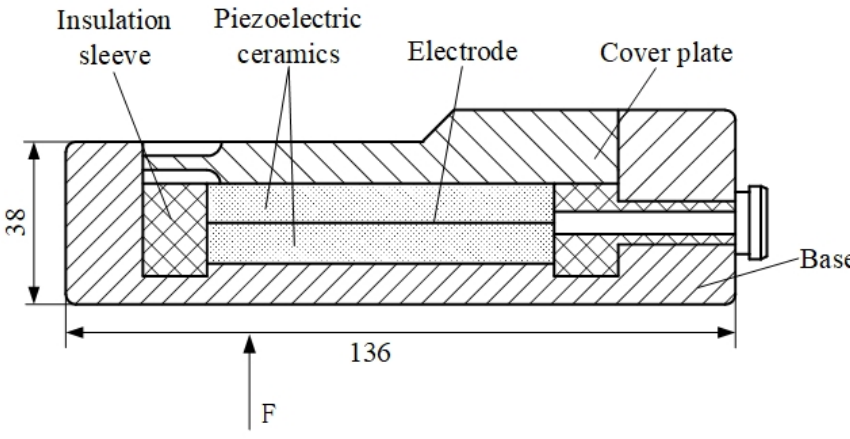
Figure 4. Structure diagram of piezoelectric sensor.